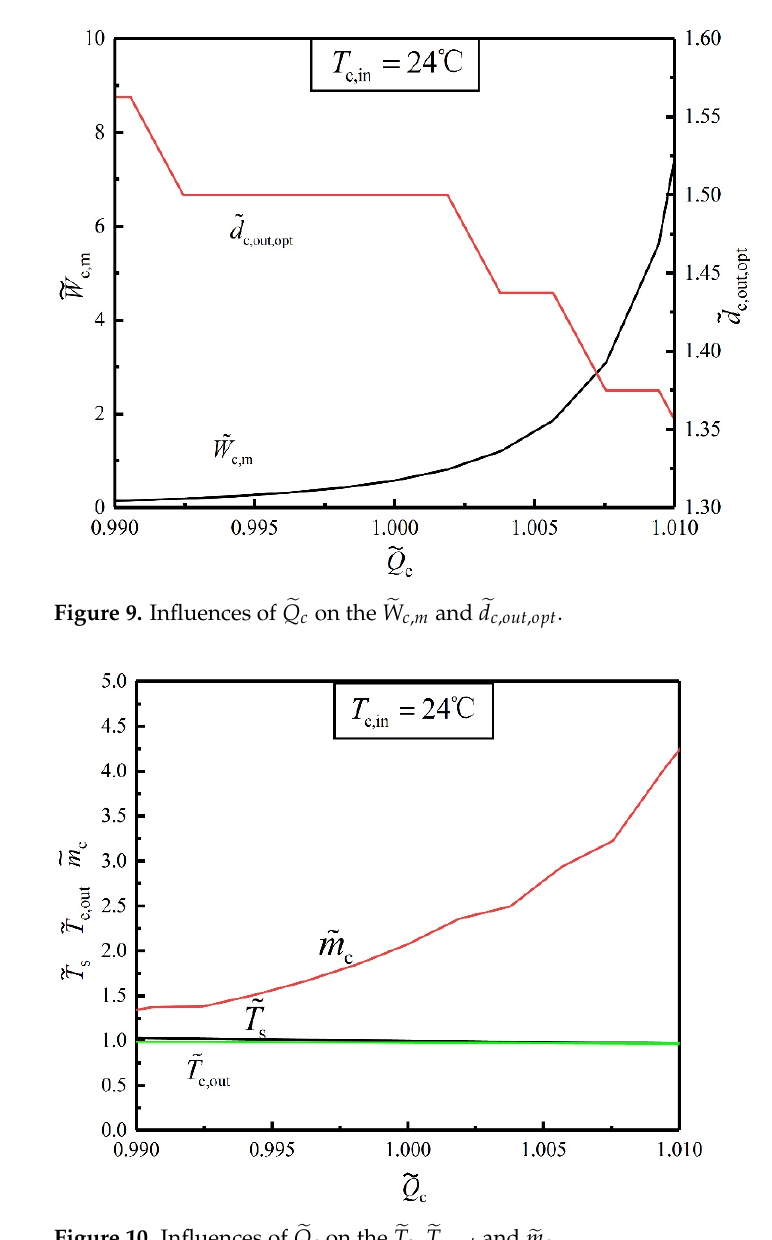
m Q  on the T  and  T  , c c , c out s